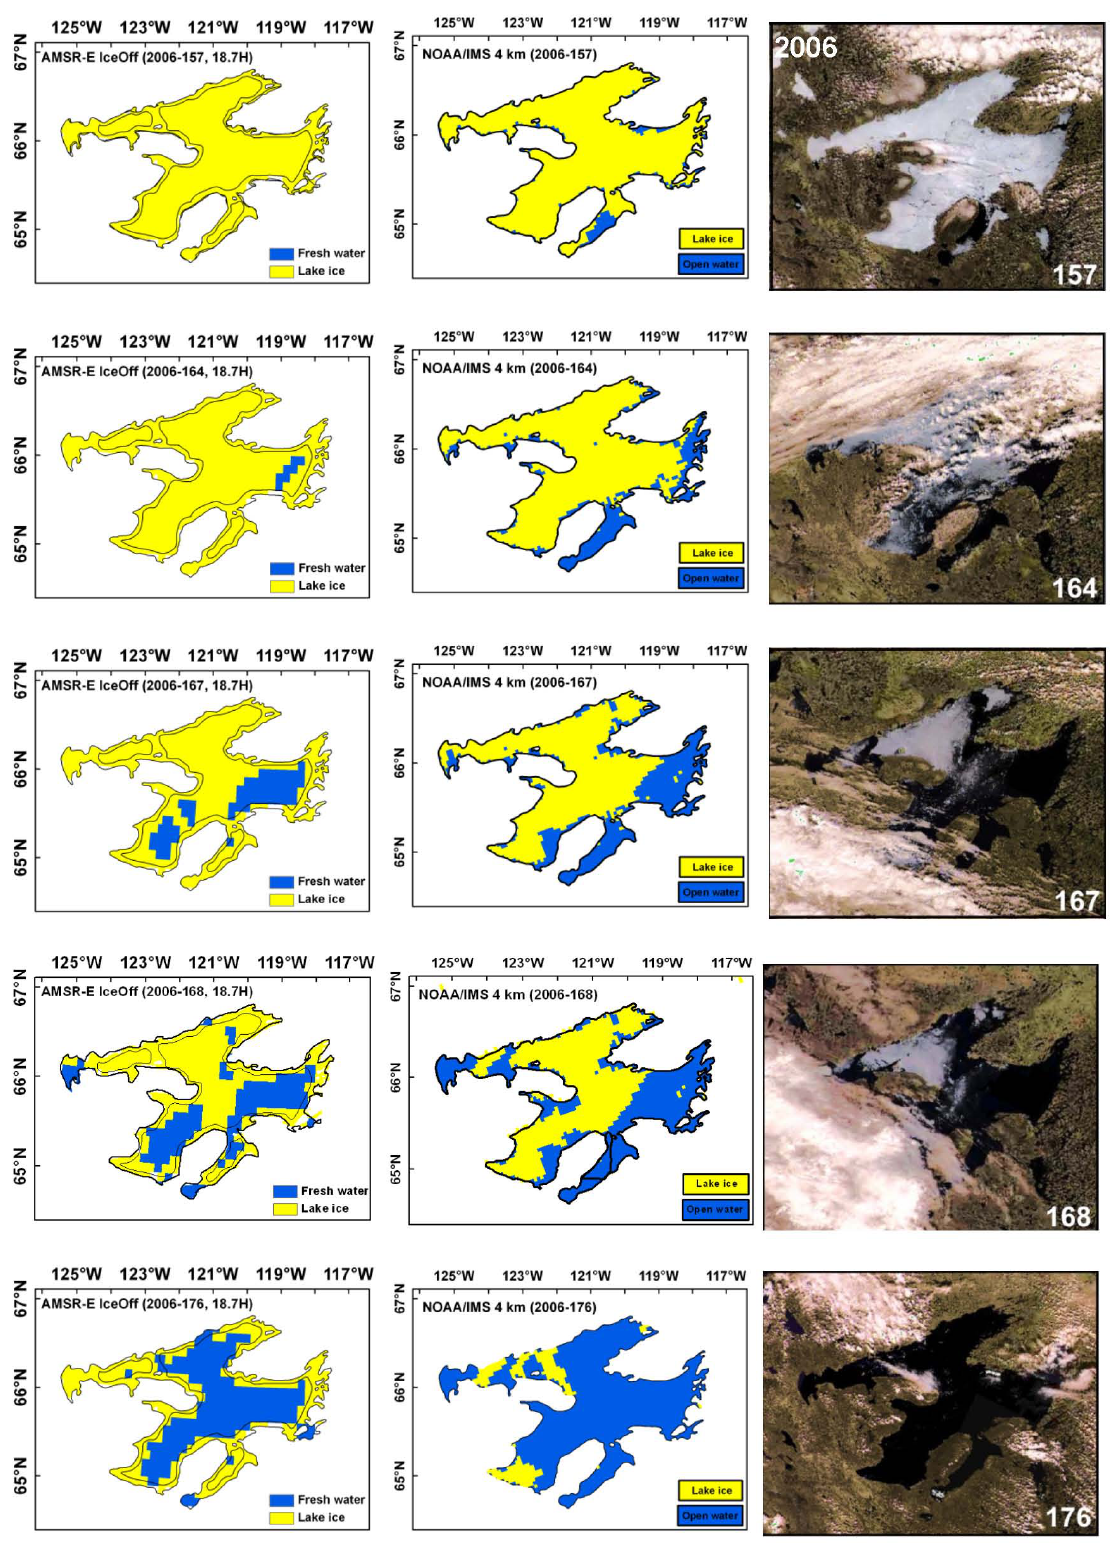
Fig. 8. Comparison of AMSR-E (left) and NOAA/IMS (center) ice-off, and MODIS/Terra image (right) acquired on the same day during the break-up period of ice season 2005–2006 on